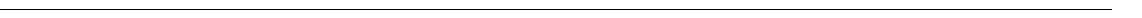
Fig. 1 KRAS is dispensable for in vitro and in vivo proliferation of PDAC cells. a Western blot con fi rmed loss of KRAS protein in knockout clones (A13-K1,K2, 8988T-H9,H36) compared to intact clones (A13-E1,E2, 8988T E3, E6). HSP90 is loading control. b RAS-GTP levels were decreased in knockout (8988T- H9 and A13-K1,K2) compared to intact (8988T E3 and A13-E1,E2) clones. GTP γ S (non-hydrolysable)-treated positive control (GTP PD) and GDP-treated negative control (GDP PD) for 8988T E3 are shown. PD pull-down. Inp input before pull-down. c KRAS de fi cient clones exhibited altered cell morphology, characterized by increased cell size, cytoplasmic translucency, and smooth edges. Scale bar is 100 µ m. d KRAS de fi cient clones showed diminished anchorage-independent growth in soft agar. Scale bar is 500 µ m. e Growth curves for A13 and 8988T KRAS intact and de fi cient (KO) clones. Average cell viability (normalized to day 0) ± s.e.m. is plotted for A13 ( n = 2 clones) and 8988T ( n = 4 clones). f A13, 8988T, and PANC-1 clones exhibited comparable ef fi ciency generating tumors following subcutaneous transplant in nude mice regardless of KRAS status. Shown are cumulative data from two KRAS intact and two de fi cient clones for A13 and 8988T and one intact and one de fi cient clone for PANC-1. g A13 KRAS de fi cient tumors grew at a slower rate than intact tumors. Average tumor volume fold increase (normalized to day 0 when tumors were ~0.5 cm in diameter) ± s.e.m. is plotted ( n = 8 tumors per